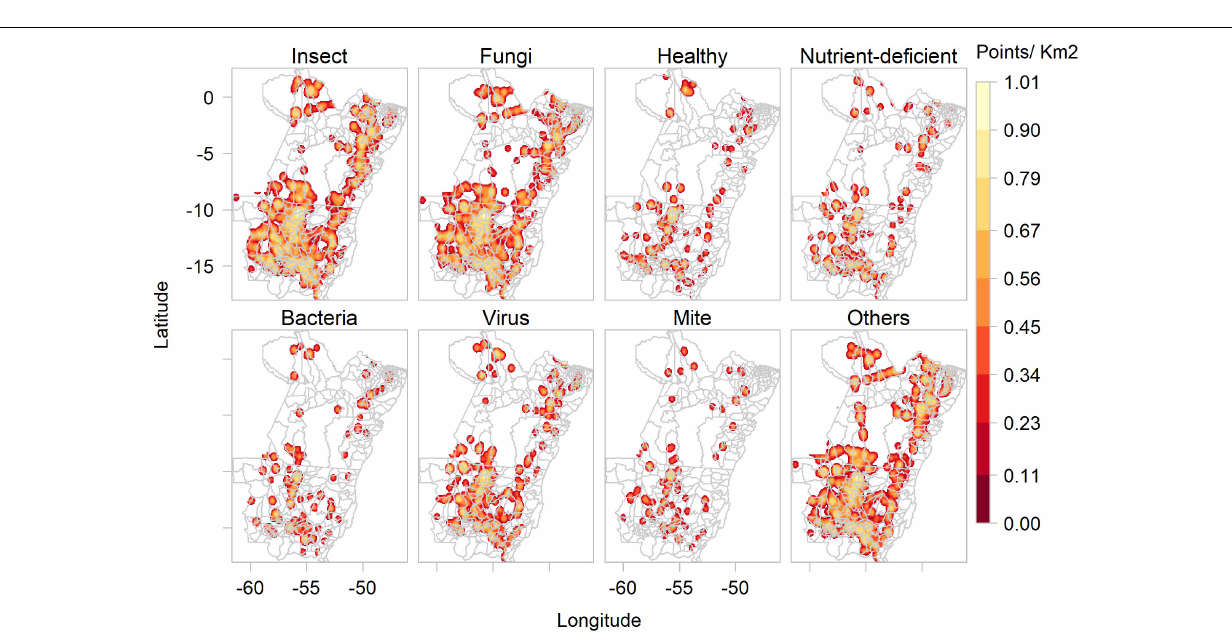
FIGURE 5 | Kernel density of images collected by Plantix users and agronomists in Mato Grosso and Pará, Brazil, between November 2016 and May 2020, according to predicted pest types and healthy